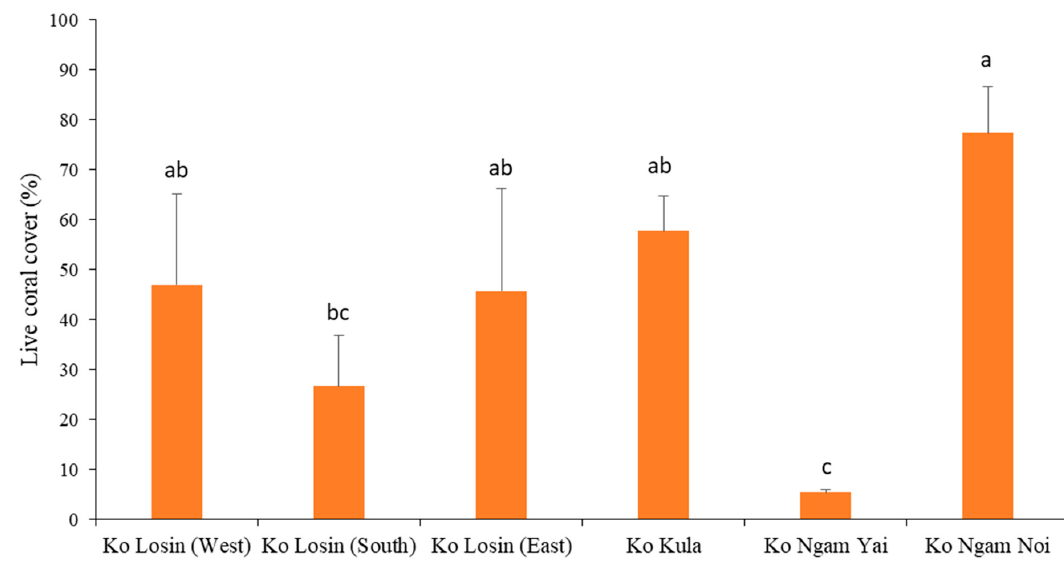
Figure 3. Live coral cover at the study sites (one-way ANOVA, p < 0.05). Error bars indicate standard deviation. Different letters above bars indicate statistical differences ( p < 0.05), as determined by Tukey’s HSD.